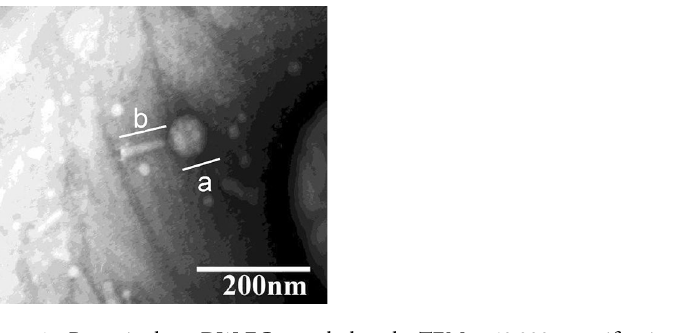
Figure 1. Bacteriophage DW-EC morphology by TEM at 40,000 magnifications with icosahedral head length ( a ) of approximately 75 nm and 85 nm for the tail length ( b